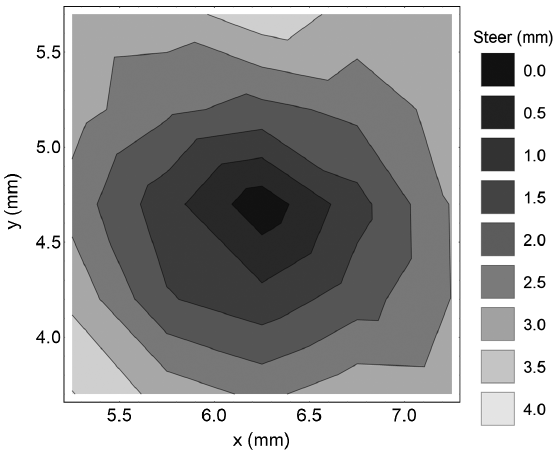
FIG. 30. Bunch charge (pC) as a function of the x , y laser position on the photocathode. The region displayed is the central field region of the photocathode.